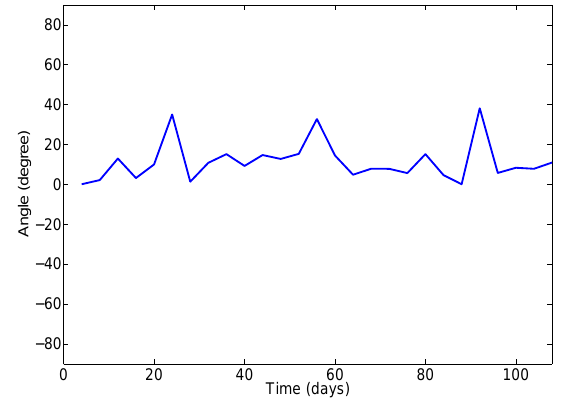
Fig. 19. Angle between the isobaths and the trajectory of float Figure 19: Angle between the isobaths and the trajectory of float 1900438 with respect to time 1900438 with respect to Temperature section for float 1900438 )